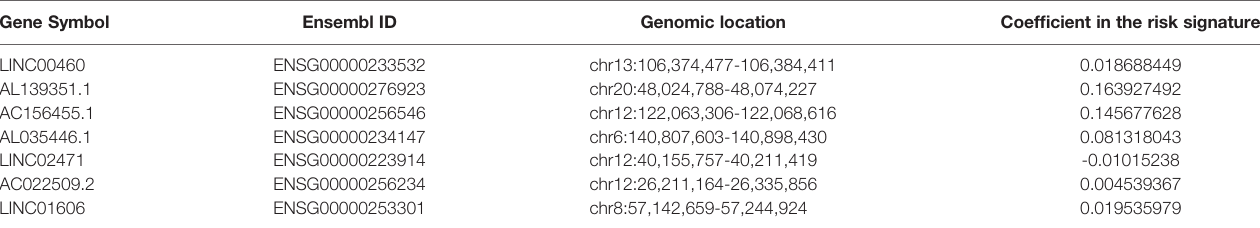
TABLE 2 | Information of the seven GID-lncRNAs composing the risk signature.